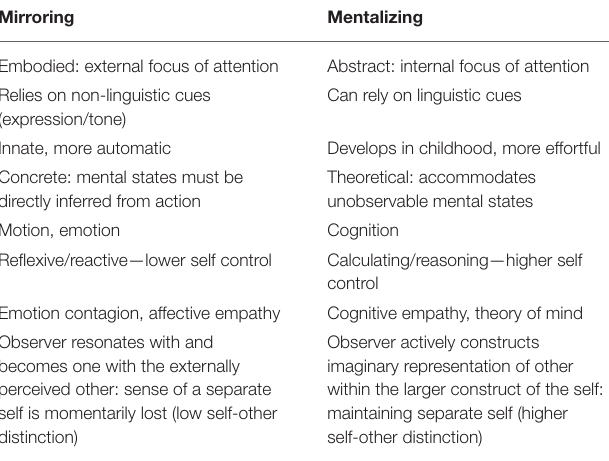
TABLE 1 | Self-other distinction and two approaches to social